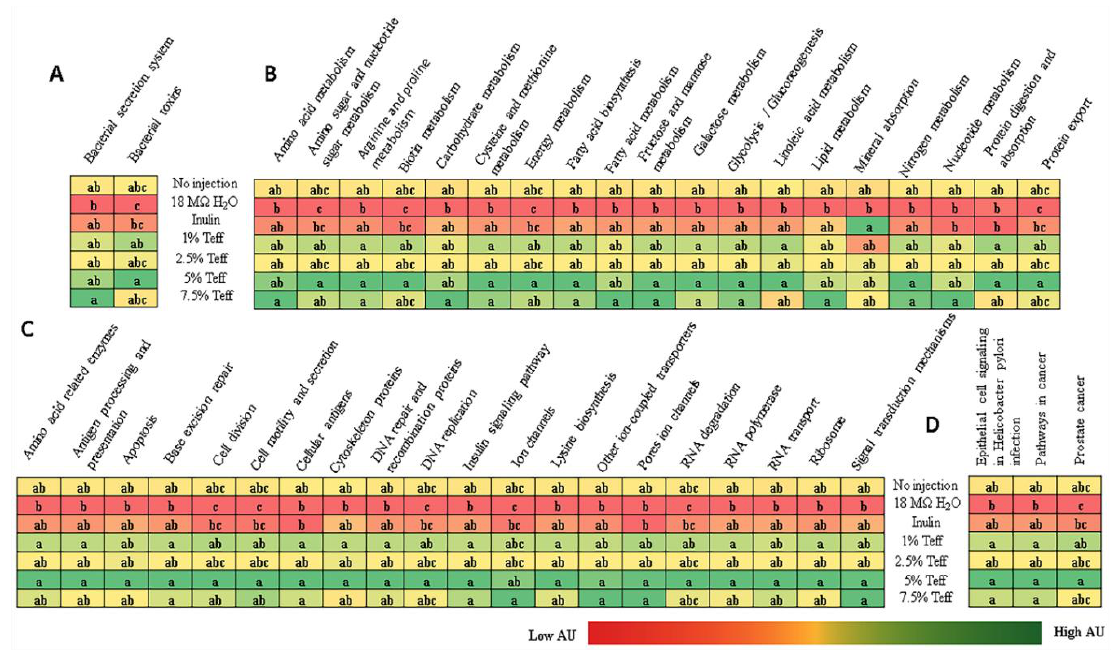
Figure 6. Predictive functional capacity of the cecal microbiota collected at hatch. ( A ) Bacterial processes; ( B ) metabolic processes; ( C ) cellular processes; and ( D ) human diseases. Treatment groups are indicated by their names and groups not indicated by the same letter are significantly di ff erent ( p <